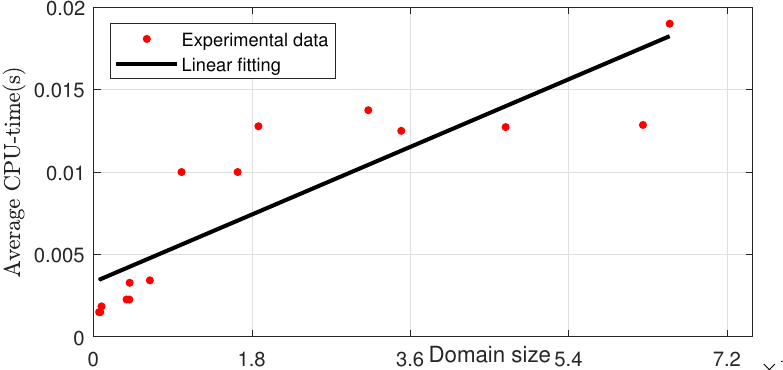
Figure 9. Experimental data and linear fitting of average CPU time per iteration versus the domain size. The average CPU time refers to the quotient of the total CPU time and the iterations. The domain size is the number of pixels within the computational